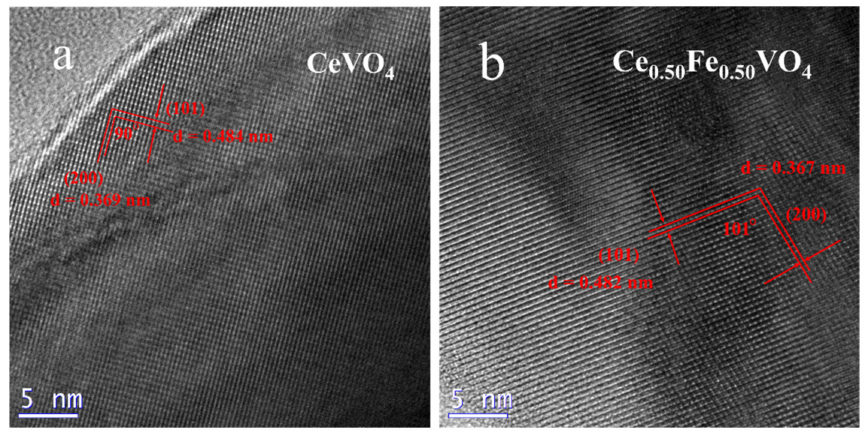
Figure 4. The HRTEM images of CeVO 4 ( a ) and Ce 0.50 Fe 0.50 VO 4 ( b ). The EDX-mapping data Ce 0.50 Fe 0.50 VO 4 (Figure 5) show the even distribution of Ce, Fe, V, and O elements. XRF data show that the Ce: Fe: V molar ratio of Ce 0.50 Fe 0.50 VO 4 is 0.507:0.493:1, close to the theoretical ratio.